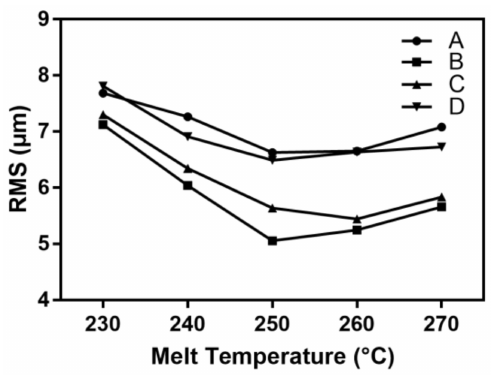
Figure 8. The influence of the melt temperature on the RMS of the